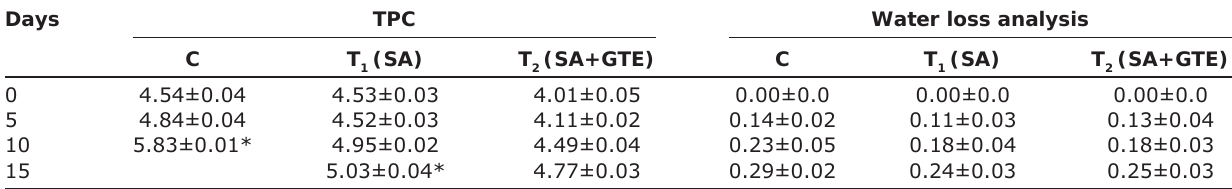
Table-3: TPC and water loss analysis (mean±SE) values of chicken meat nuggets as influenced by different coatings during refrigerated (4±1°C) storage. Days TPC